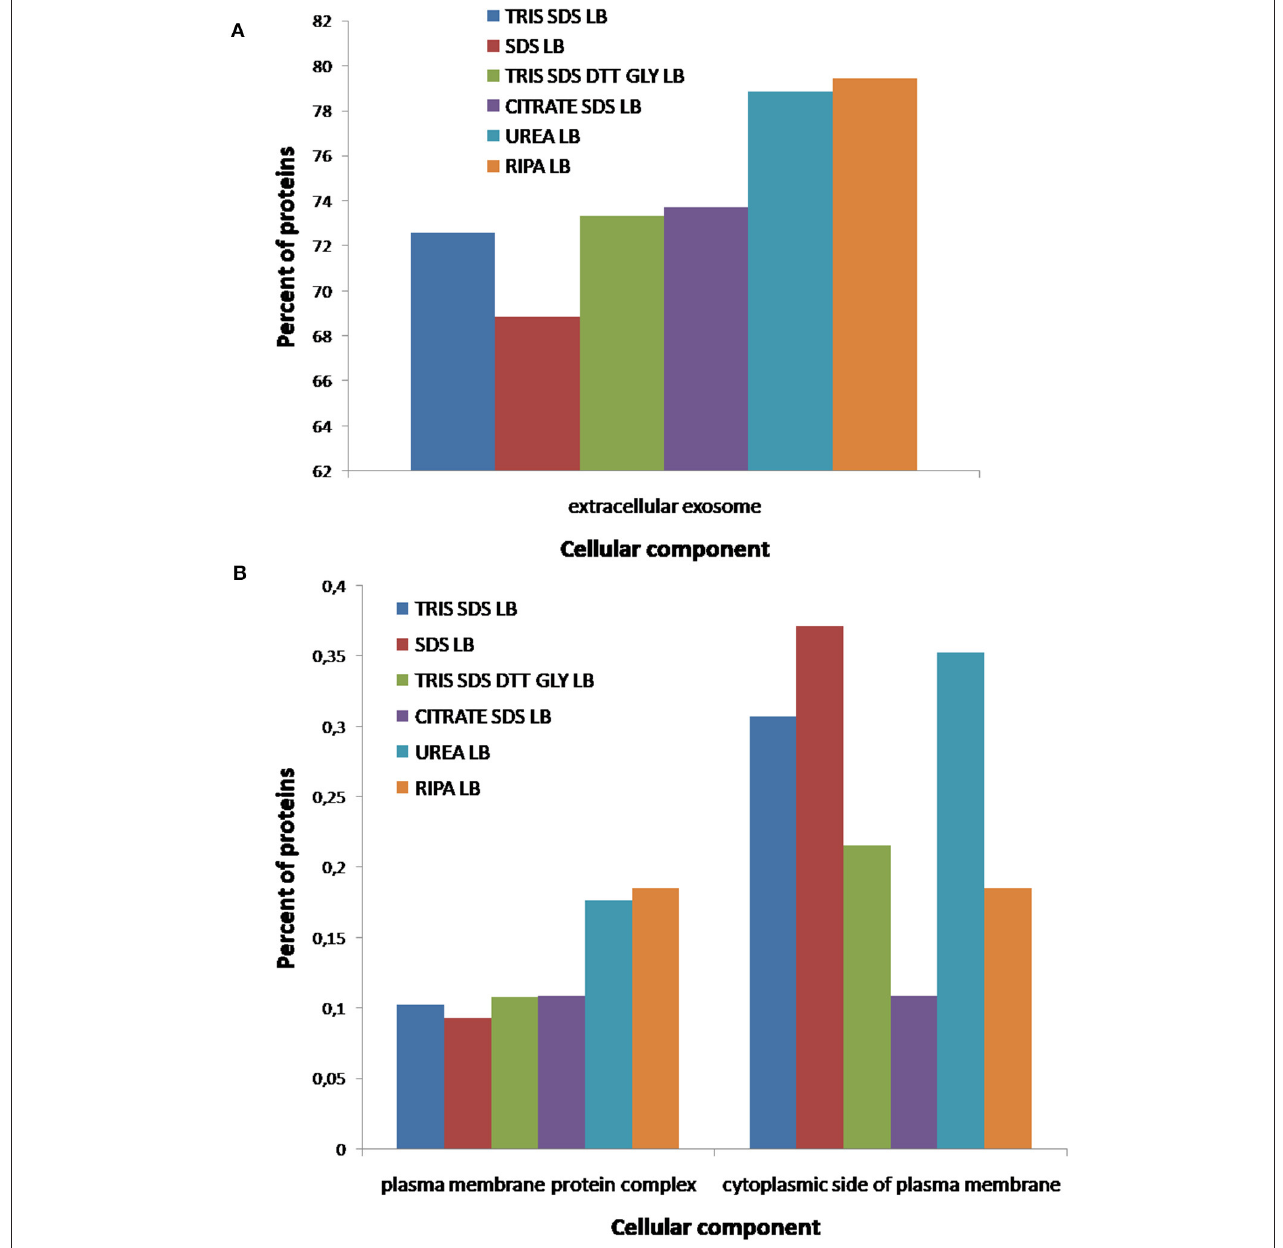
FIGURE 9 | Functional classification of all proteins identified after the extraction with the six different buffers [ buffer 1 (Tris-SDS LB), n = 979 proteins; buffer 2 (urea LB), n = 569 proteins; buffer 3 (Tris-SDS-DTT-Glycerol LB), n = 930 proteins; buffer 4 (citrate-SDS LB), n = 921 proteins; buffer 5 (SDS-LB), n = 1,086 proteins; buffer 6 (RIPA LB), n = 540 proteins], according to their cellular component: (A) extracellular exosomes, (B) plasma membrane complex and cytoplasmatic side of plasma membrane, using the FunRich